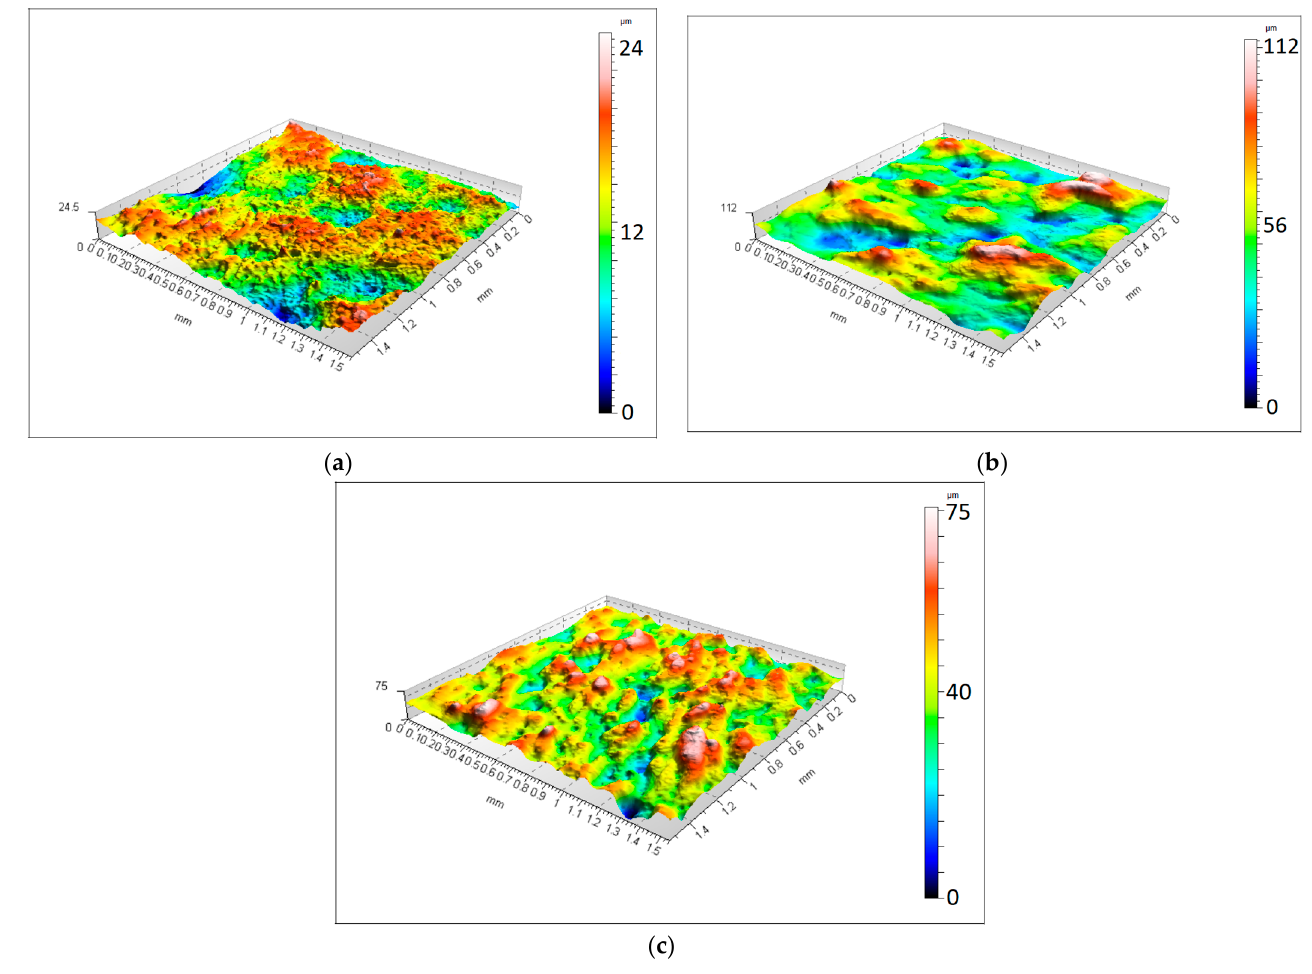
Figure 2. Isometric view of the surface after removal of the shape ( a ) 0°, ( b ) 45° and ( c ) 90°.